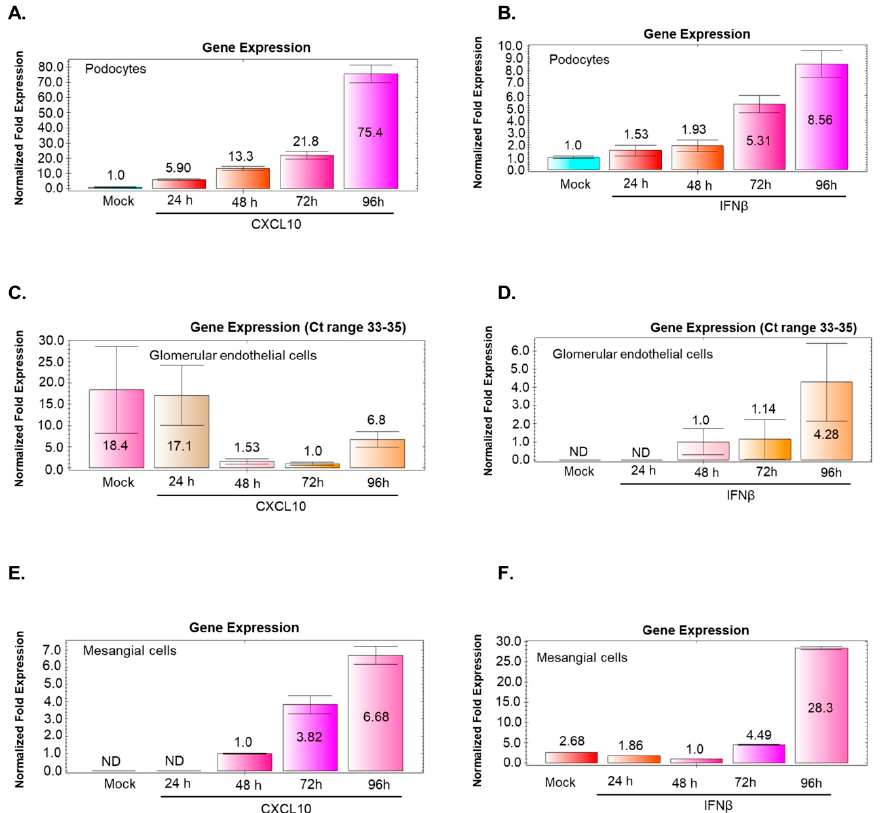
Figure 8. Time course analysis of CXCL10 and IFN β gene expression in BKV-Infected GVU cells. ( A , B ) qRT-PCR analysis CXCL10 and IFN β gene expression in mock-infected undi ff erentiated podocytes and podocytes infected with BKV for 24, 48, 72, and 96 h, respectively. ( C , D ) qRT-PCR analysis CXCL10 and IFN β in mock-infected glomerular endothelia cells and glomerular endothelial cells infected with BKV for 24, 48, 72, and 96 h, respectively. Note that Ct values for CXCL10 and IFN β gene expression are in the range of 33–35, below statistical significance ( E , F ). qRT-PCR analysis CXCL10 and IFN β in mock-infected mesangial cells and mesangial cells infected with BKV for 24, 48, 72, and 96 h respectively. PCR results were normalized to